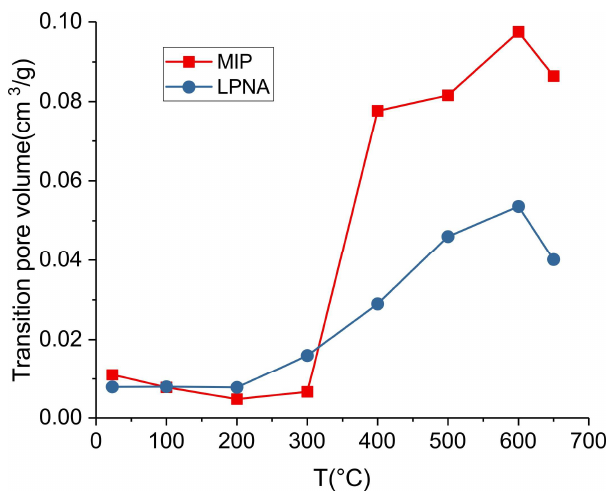
Figure 9. The relationship between transition pore volume and temperature from MIP and